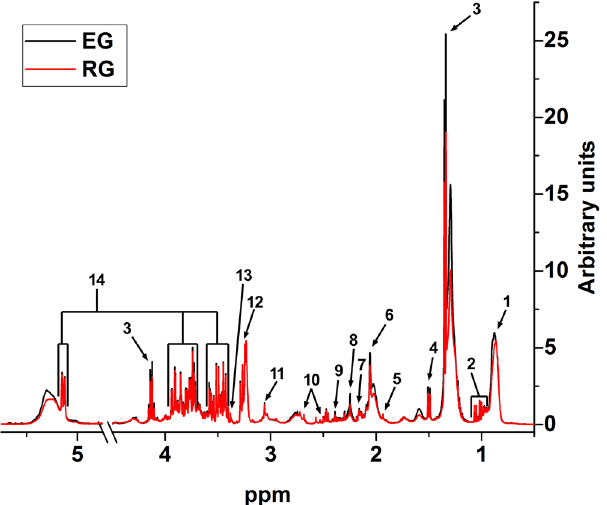
Figure 1. Mean 1H-CPMG spectra of serum samples obtained from the EG and RG groups. Main detected metabolites are indicated: 1, lipids; 2, BCAA (branched chain amino-acids: leucine, isoleucine and valine); 3, lactate; 4, alanine; 5, acetate; 6, N-acetyl-glycoprotein (NAG); 7, glutamine; 8, acetone; 9, pyruvate; 10, citrate; 11, creatinine; 12, choline; 13, methanol; 14, glucose.